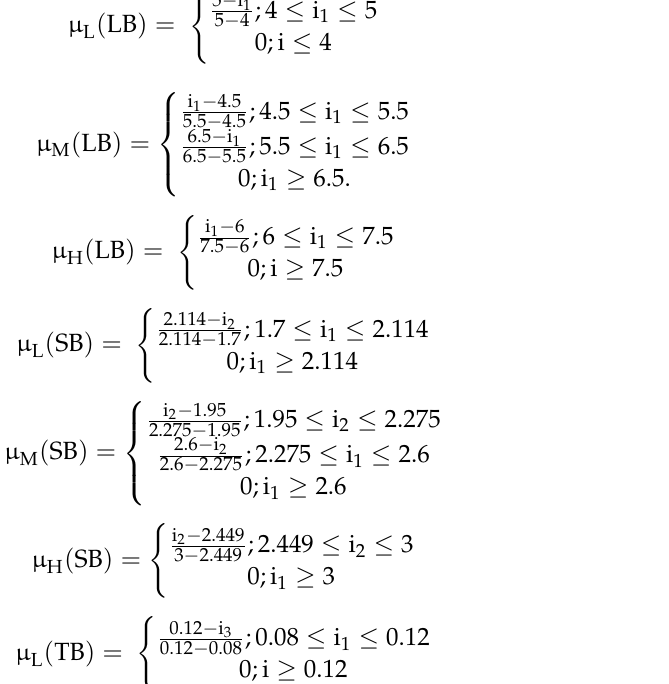
Figure 7. Surface view of load at break (X-axis) and strain at break (Y-axis) effect on jute yarn quality (Z-axis); ( a ) for triangular membership function and ( b ) gaussian membership function.